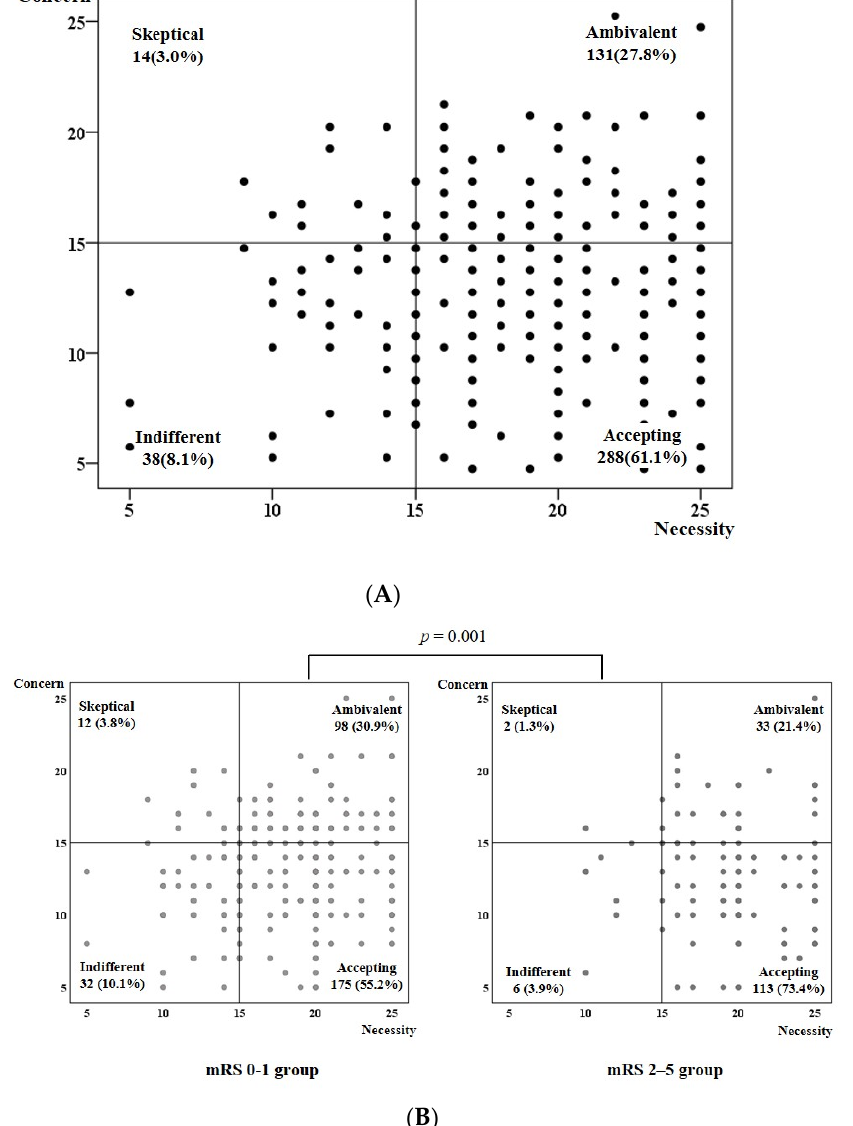
Figure 1. Belief attitudes about medication in ischemic stroke patients. ( A ) Shows belief attitudes towards medication of all stroke patients ( n = 471). ( B ) Shows the differences in the belief attitudes about medication between mRS 0–1 group ( n = 317) and mRS 2–5 group ( n = 154), which are significantly different ( p = 0 . 001) .